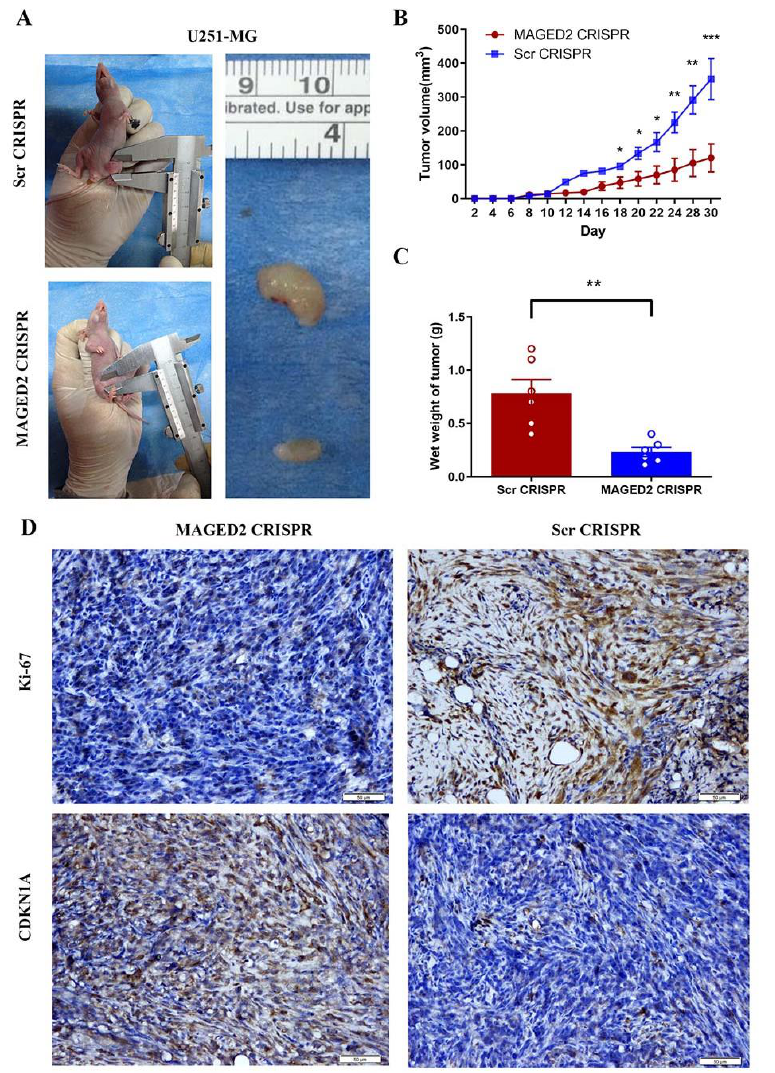
Figure 8. MAGED2 promoted glioma cell proliferation in vivo. The glioma cell growth of the U251- MG cell line was determined by xenograft model assay in vivo. U251-MG- MAGED2 CRISPR and Scramble CRISPR cells were transplanted subcutaneously into nude mice and monitored every 2 days ( A ). Tumor growth curves were determined ( B ), and tumor weight ( C ) was shown. The error bar represents the SD of the mean value. Statistical analysis was determined by two-tailed Student’s t -test. * p < 0.05, ** p < 0.01, *** p < 0.001; n = 6/group. ( D ) MAGED2 downregulation inhibits the growth of glioma cells in vivo. Ki-67 and CDKN1A in tumors are assessed in U87 cells by IHC assay after treatment with MAGED2 CRISPR and Scramble CRISPR. Scale bar: 50 μm.